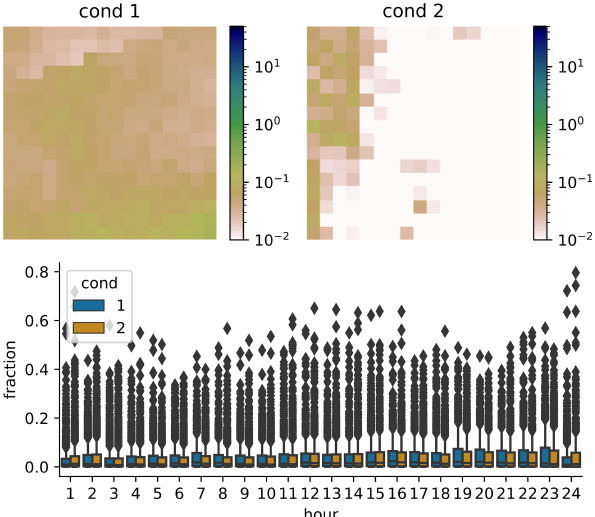
Figure D1. Example of daily area mean distributions generated from two different daily sum conditions. For each condition, 1000 scenarios were generated. In all bar plots, outliers are not shown. The same plots as Fig. 9 but with